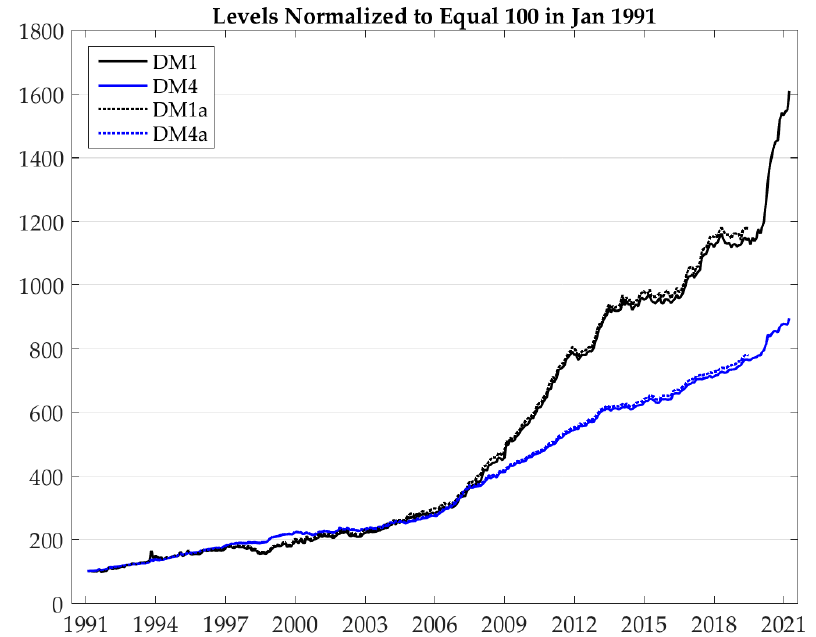
Figure 3. Divisia and credit-card-augmented Divisia monetary aggregates, 1991–2021. DM2, DM3, and DM4 have almost identical growth rates, but they are substantially different from the growth rate of DM1. As shown in Figure 2, DM2, DM3 and DM4 almost lie on top of each other. To explain this fact, refer to Tables 3 and 4 for the growth-rate weights of the components in the Divisia monetary aggregates. While DM1 contains only two components, currency and demand deposits, their weights for the latest months in our sample (Mar 2021) are 20.66% and 79.34%, respectively, as presented in Table 3.